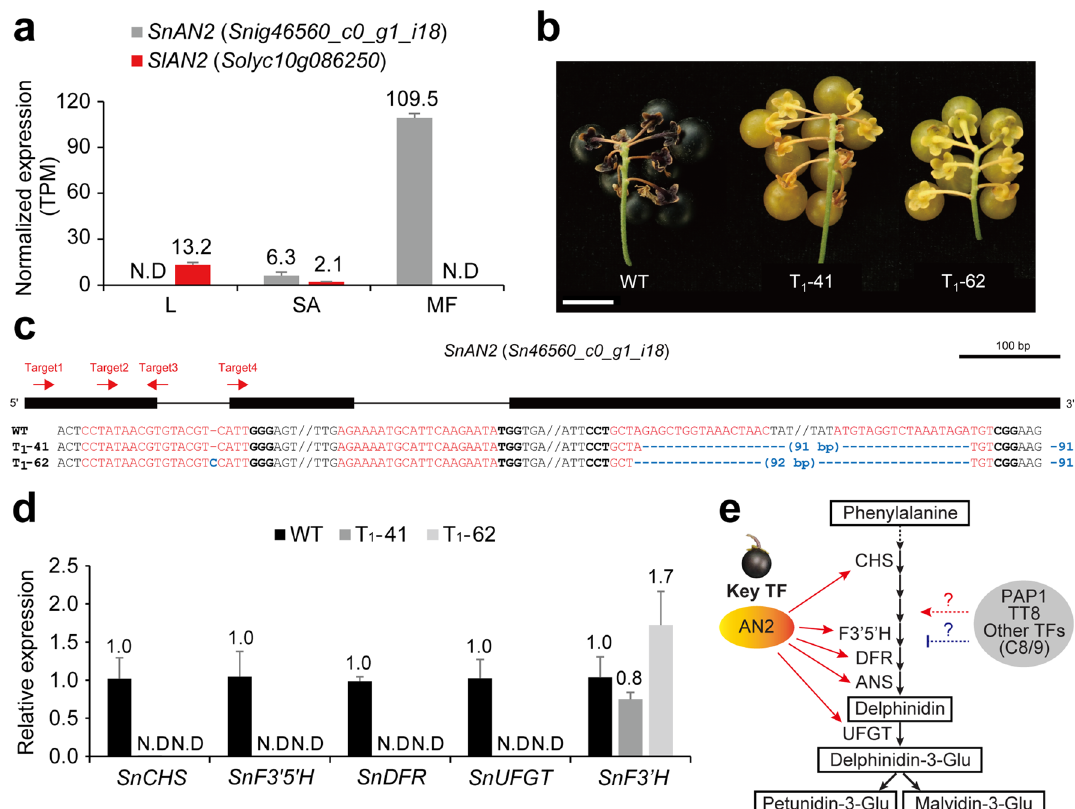
Figure 6. SnAN2 transcription factor activates flavonoid biosynthetic genes. ( a ) Comparison of SnAN2 and SlAN2 expression. L, leaf; SA, shoot apex; MF, mature fruit. Data are shown as mean ± standard deviation. N.D, not detected. ( b ) Representative image of wild-type (WT) and two independent snan2-cr mutants for T 1 generation. Scale bar, 1 cm. ( c ) Gene structure of WT and alleles of the snan2-cr mutants. Red and three bold characters, each target (sgRNA) and protospacer adjacent motif (PAM) site. Blue characters, each mutation. ( d ) qRT-PCR results of downstream genes regulated by SnAN2 . Expression levels of each gene were normalized with the value of WT and UBIQUITIN was used as the endogenous control. Data are shown as mean ± standard deviation: n = 4, biological replicates. N.D, not detected. ( e ) Proposed model for the molecular regulation of flavonoid biosynthesis in the fruits of S. nigrum . Red arrows (left) indicate the positive regulation shown in this study. Red dashed-arrow and blue dashed-line (right) represent predicted positive and negative regulations. TF, transcription factor. C8/9, Cluster 8 and 9 defined in Fig.